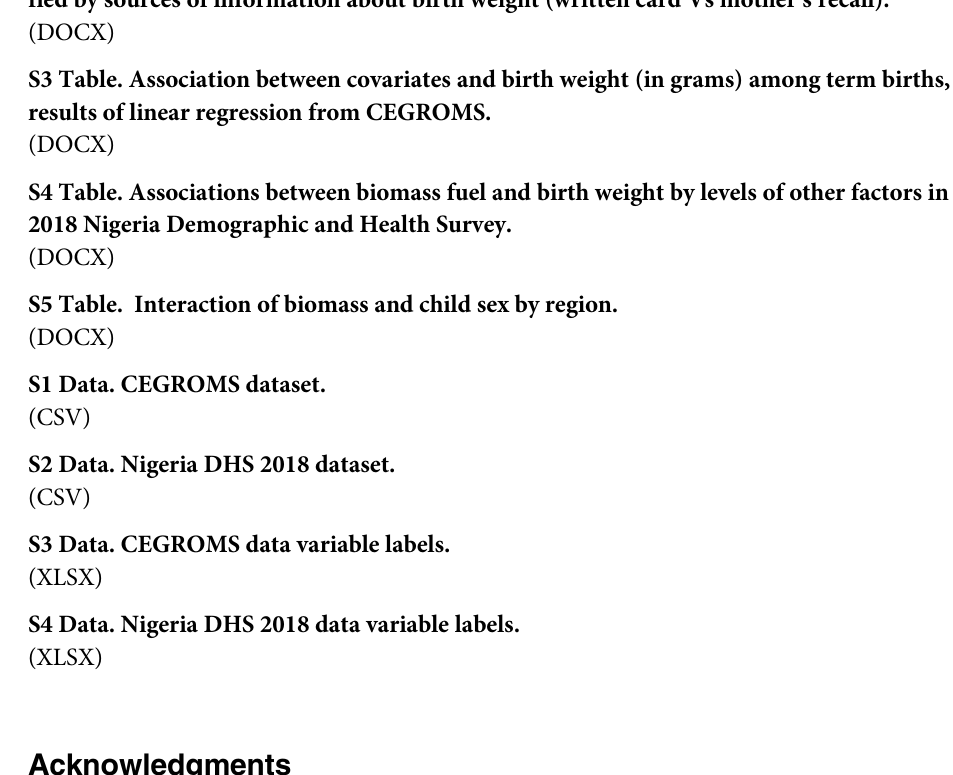
S1 Table. Sensitivity analysis: 2018 Nigeria DHS maternal and infant characteristics strati- fied by participation status. S2 Table. Sensitivity analysis: 2018 Nigeria DHS maternal and infant characteristics strati- fied by sources of information about birth weight (written card Vs mother’s recall). S3 Table. Association between covariates and birth weight (in grams) among term births, results of linear regression from CEGROMS. S4 Table. Associations between biomass fuel and birth weight by levels of other factors in 2018 Nigeria Demographic and Health Survey. S5 Table. Interaction of biomass and child sex by